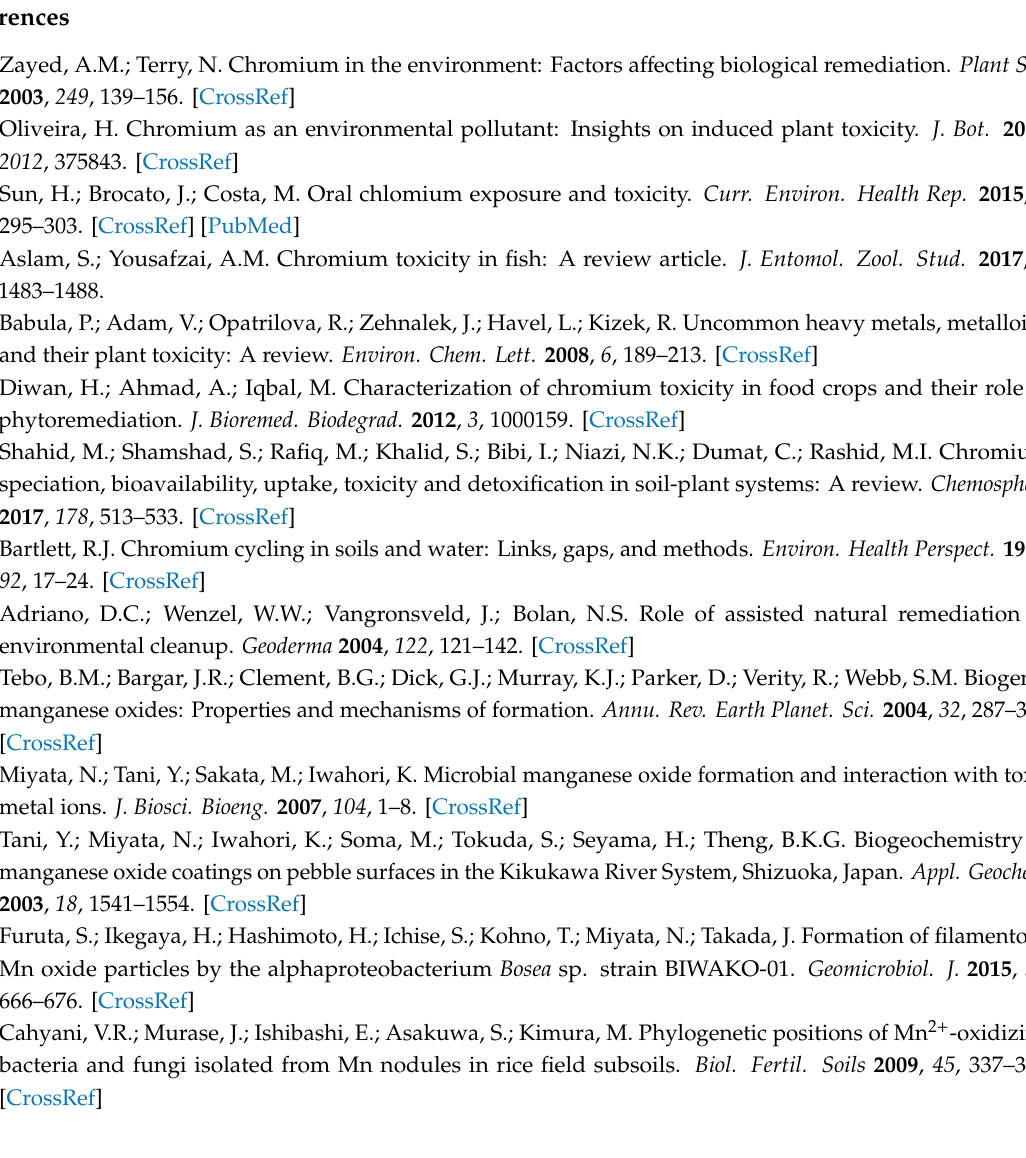
Abbreviations, Figure S1: Release of Mn(II) during single treatments of BMOs in Cr(NO 3 ) 3 . Figure S2: Stability of dissolved 0.5 mM